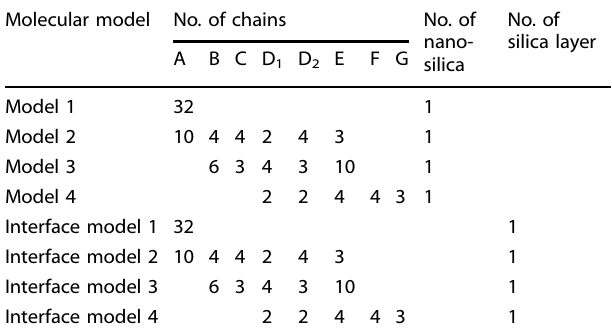
Table 1. Constructions of the unaged and aged molecular models.